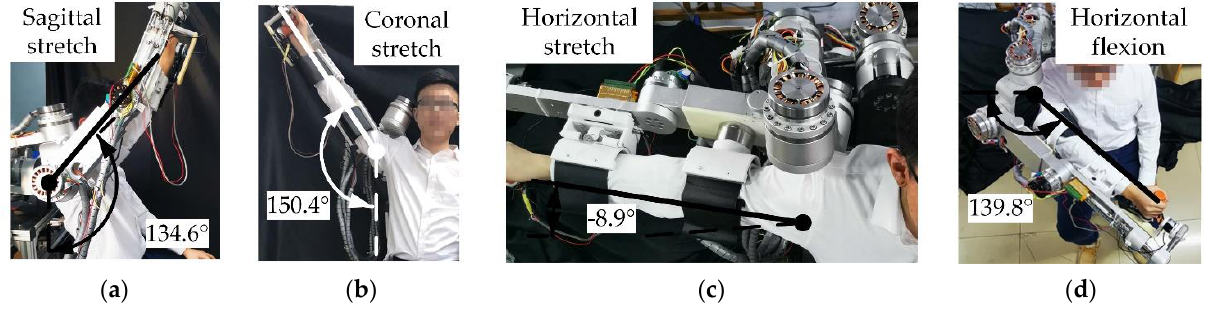
Figure 23. Movement states of human upper limbs in the prototype. ( a ) Sagittal stretch; ( b ) coronal stretch; ( c ) horizontal stretch; ( d ) horizontal flexion.